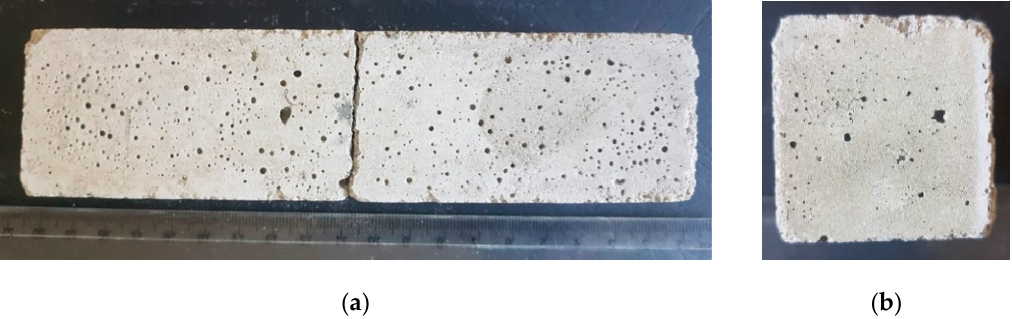
Figure 6. Portland cement-based binder CEM I 42.5R with 30% added ground slag from MSWI 2 incineration plant ( a ) front, ( b ) side.